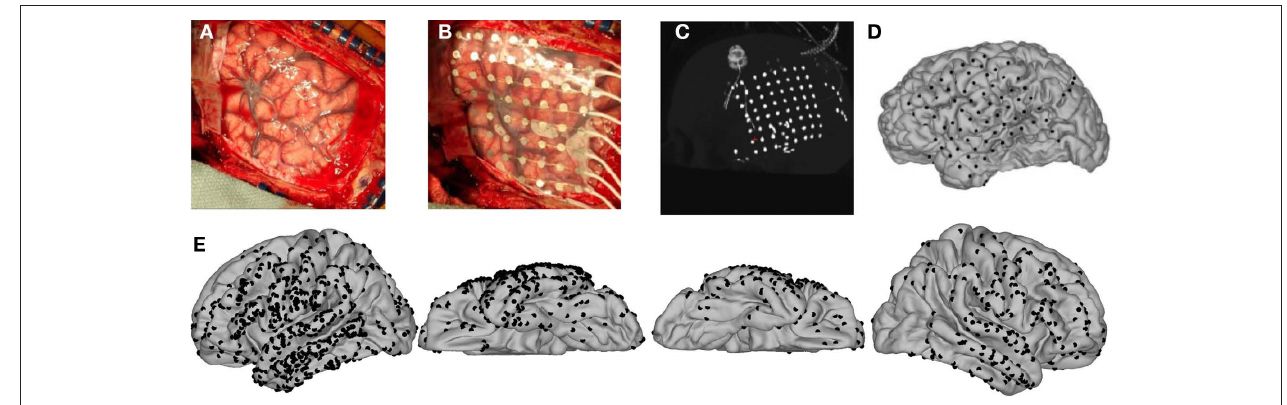
of the intracranial electrodes collapsed onto a single plane. (D) Electrodes overlaid onto a 3D rendering of the patient’s cortical surface. (e) Summary of all individual electrode sites. Electrode coordinates from all nine participants in the study were co-registered and overlaid onto the FreeSurfer average surface. In total, we sampled from nearly 1000 sites, mostly over lateral cortex.